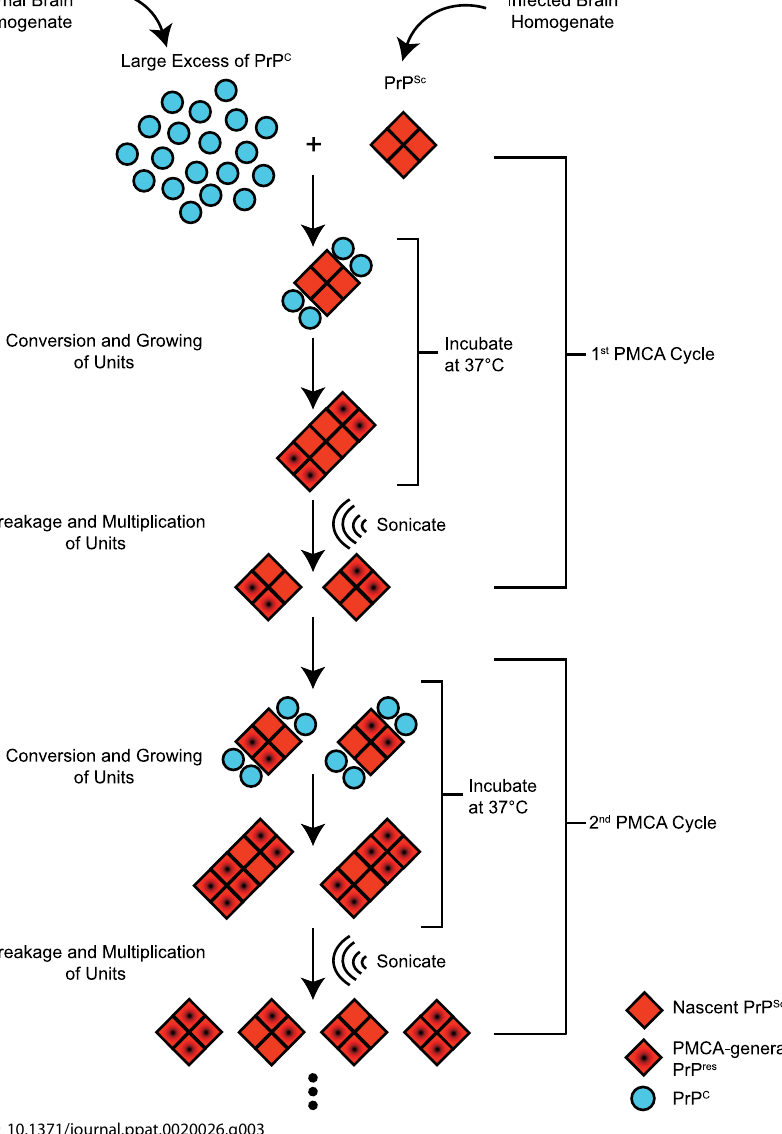
Figure 3. Schematic Representation of the PMCA Procedure Brain homogenate from an infected animal (containing PrP Sc ) is diluted into homogenate from a healthy animal (containing PrP C ) and incubated at 37 8 C. During this stage, some molecules of PrP C are converted to PrP res and are added to the growing PrP res unit. Sonication breaks up PrP res into smaller units, generating new seeds for conversion. These steps are repeated in a cyclic fashion in order to amplify the amount of PrP res present in the initial sample. The stoichiometry and directionality of amplification depicted are for illustrative purposes only and are not meant to represent intrinsic properties of the